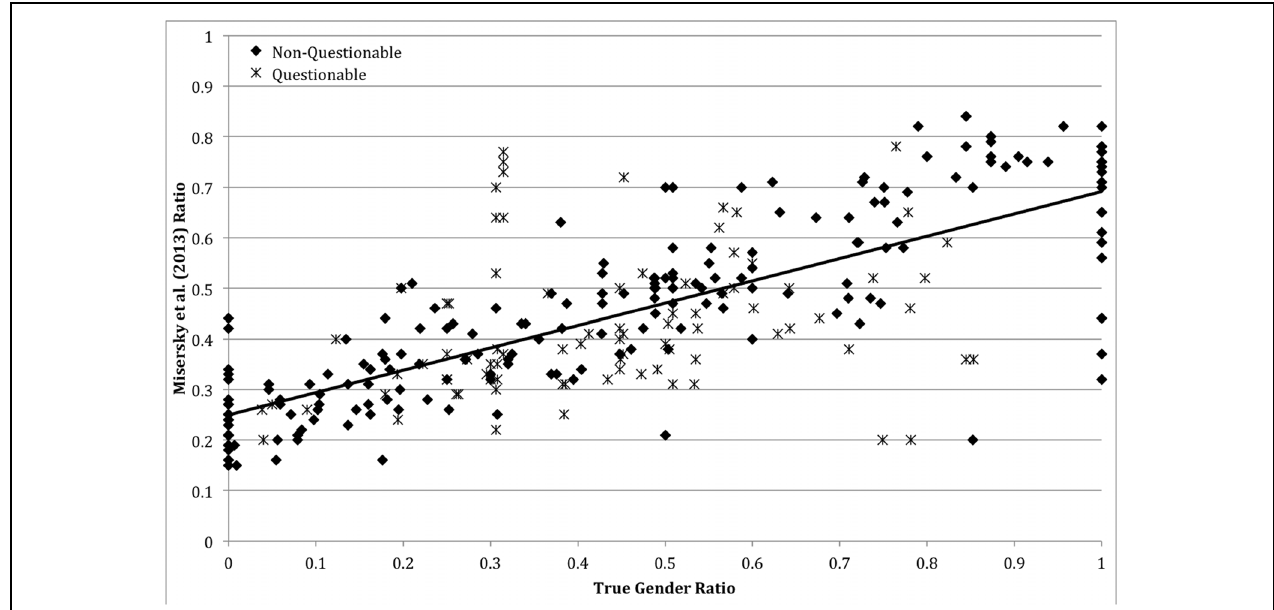
FIGURE 1 | Scatter plot of real gender ratios from current study against normative judgments from Misersky et al. (2014). The solid line is the line of best fit for all data.